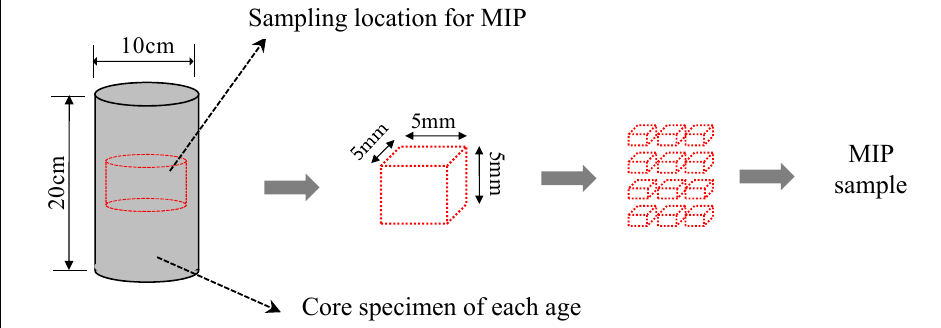
Figure 6. Sampling of a specimen for mercury intrusion porosimeter (MIP).